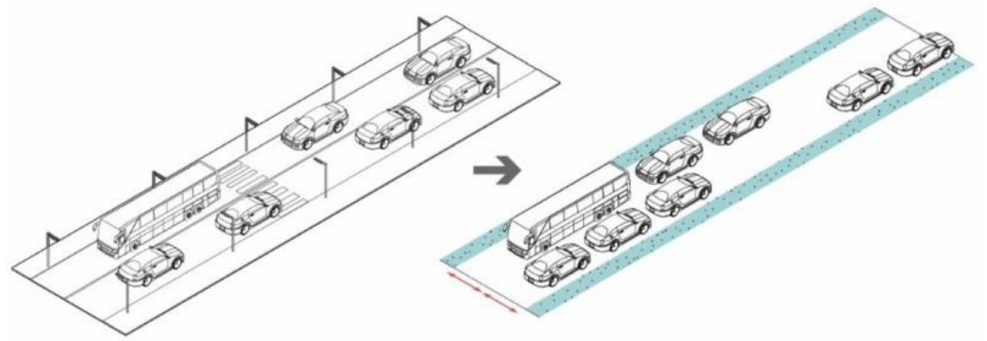
Figure 7. Supposed more efficient utilisation of the carriageway given by the development of CAVs [48].